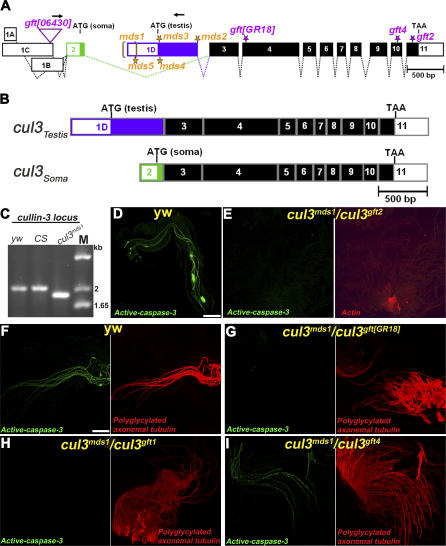
The cul3mds1–5 Alleles Contain Mutations in a New Exon of the cullin-3 Gene(A) Genomic organization of the cullin-3 locus. Thick bars indicate exons and dotted lines indicate introns. Solid bars indicate coding sequences, whereas open bars indicate UTRs. The Drosophila cullin-3 gene contains 14 exons, nine of which encode the bulk of the protein (exons 3–11) and are shared by both the somatic and testis-specific isoforms. While the three somatic isoforms (cul3Soma) differ in their 5′ UTRs, each beginning with a unique first exon (exons 1A, 1B, and 1C), they share a second, somatic-only exon that contains a start codon (exon 2, green bar). The testis isoform, cul3Testis, begins with a unique first exon (1D, blue bar) that includes both 5' UTR and coding sequences, including a start codon. The relative locations of the molecular lesions in cul3Testis (orange, cul3mds1–5 alleles) and cul3Soma (purple, cul3gft2, 4, GR18 alleles) are shown with stars (see the main text for more details on the precise molecular lesions of the cul3mds1–5 alleles). The molecular alterations of the cul3gft alleles were reported in [71]: cul3gft06430 contains a PZ element insertion 228 nucleotides from exon 2 (the insertion is indicated by a purple triangle). cul3gft[GR18] is missing a single nucleotide causing a premature stop codon at amino acid 167. cul3gft4 bears a C-to-T transversion, which results in an A710-to-V conversion. cul3gft2 contains a five-nucleotide deletion that results in a premature stop codon at amino acid 748 that removes half of the C-terminal Cullin homology domain (CHD).(B) A scheme of the two major mRNA isoforms of cullin-3, cul3Testis, and cul3Soma.(C) Genomic PCR and sequencing analyses of the cullin-3 locus revealed a 181-bp deletion in cul3mds1 (the arrows in A depict the relative locations of the primers used in this gPCR; yw and Canton S strains were used as wild-type controls).(D) For positive control, wild-type spermatids were stained for cleaved caspase-3 expression (green).(E) Consistent with the idea that both the mds and gft alleles affect the same gene, cullin-3, cul3mds1/cul3gft2 transheterozygote mutant spermatids displayed defects in individualization and negatively stained for cleaved caspase-3 (left panel). Spermatids were counter-stained with phalloidin that binds to F-actin in the spermatids' tail (right panel, red; the strong red staining at the bottom corresponds to remnants of the testis sheath).(F–I) Spermatids were stained for cleaved caspase-3 (green in left panels) and for axonemal tubulin polyglycylation (red in right panels).(F) Wild-type control testis positively stained for cleaved caspase-3 and axonemal tubulin polyglycylation.(G–I) Whereas transheterozygous combinations between cul3mds1 and the strong cul3gft[GR18] (G) or cul3gft1 (H) alleles displayed spermatid individualization defects and stained negatively for cleaved caspase-3 and positively for polyglycylation, mutant spermatids from cul3mds1 in trans to the hypomorphic cul3gft4 allele also exhibited individualization defects but displayed reduced level of cleaved caspase-3 expression (I).All the figures were taken at the same magnification; scale bars, 200 μm.